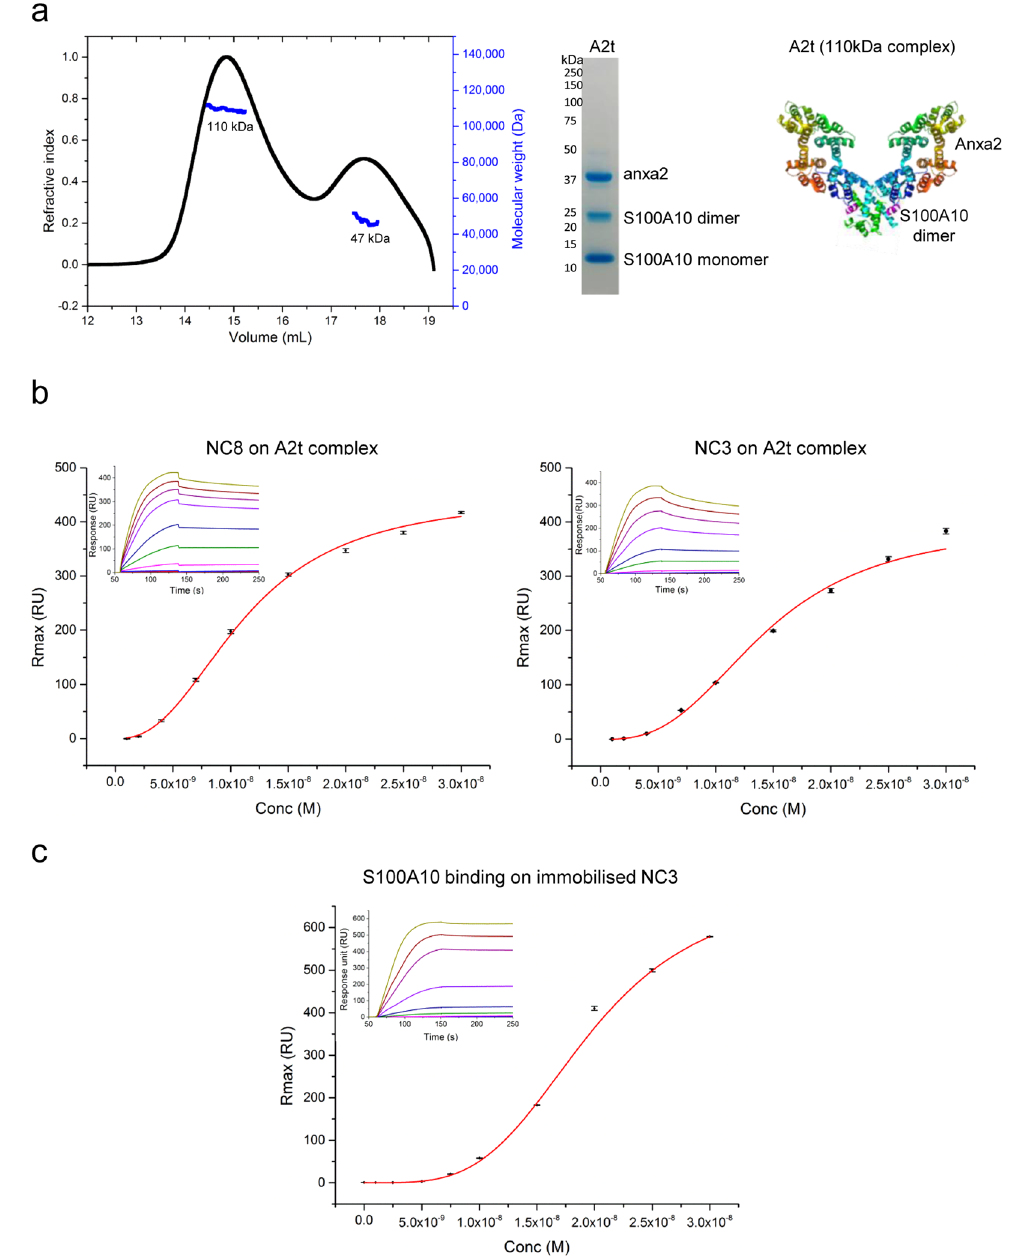
Figure 2. PLA 2 R interacts with A2t complex via S100A10. ( a ) Left , characterisation of Annexin2-S100A10 complex in solution using Multi Angle Laser Light Scattering (MALLS). The elution profile reveals 2 peaks, 110 kDa referred as A2t (Anxa2/S100A10 heterotetramer) and 47 kDa complex. Middle , 10 µ g of purified complex ran on a non-reduced SDS-PAGE gel and stained with Instant Blue confirm the presence of both Anxa2 and S100A10 proteins in various oligomeric forms. Right , schematic representation of A2t complex made of a S100A10 dimer (10.2210/pdb1BT6/pdb) and two Anxa2 molecules (10.2210/pdb2hyw/pdb). ( b ) SPR data showing direct interaction with PLA 2 R fragments and A2t complex. Purified PLA 2 R NC8 and NC3 at various concentrations (0 to 300 nM) were injected over the surfaces of immobilised A2t. The maximal response (RU max ) were obtained from the sensograms (inset) and plotted against the increasing concentrations of injected PLA 2 R. Each data point in both experiments is the mean of 3 repeats. The equilibrium dissociation constant, K D , was calculated by fitting the data to the Hill equation using nonlinear regression. ( c ) Representative sensorgrams derived from injections of different concentrations of purified recombinant S100A10 protein over immobilised PLA 2 R NC3. Results were obtained after reference